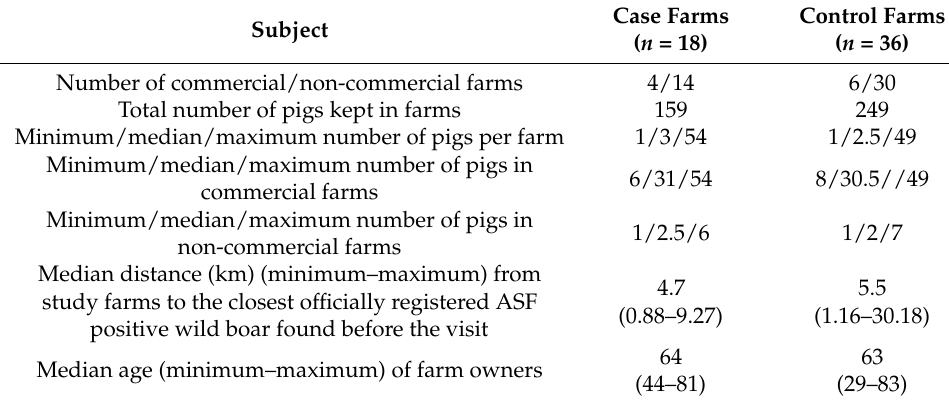
Table 2. Information of case and control farms given in the questionnaire within the framework of the case-control study on the risk of African swine fever introduction to pig farms in Lithuania in